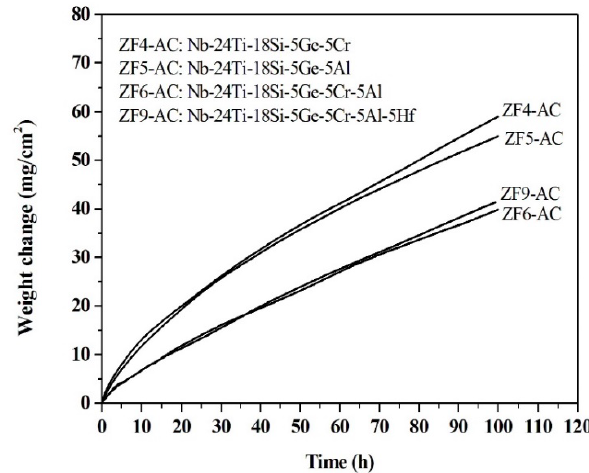
Figure 11. The TG data after isothermal oxidation at 1200 ◦ C for 100 h.